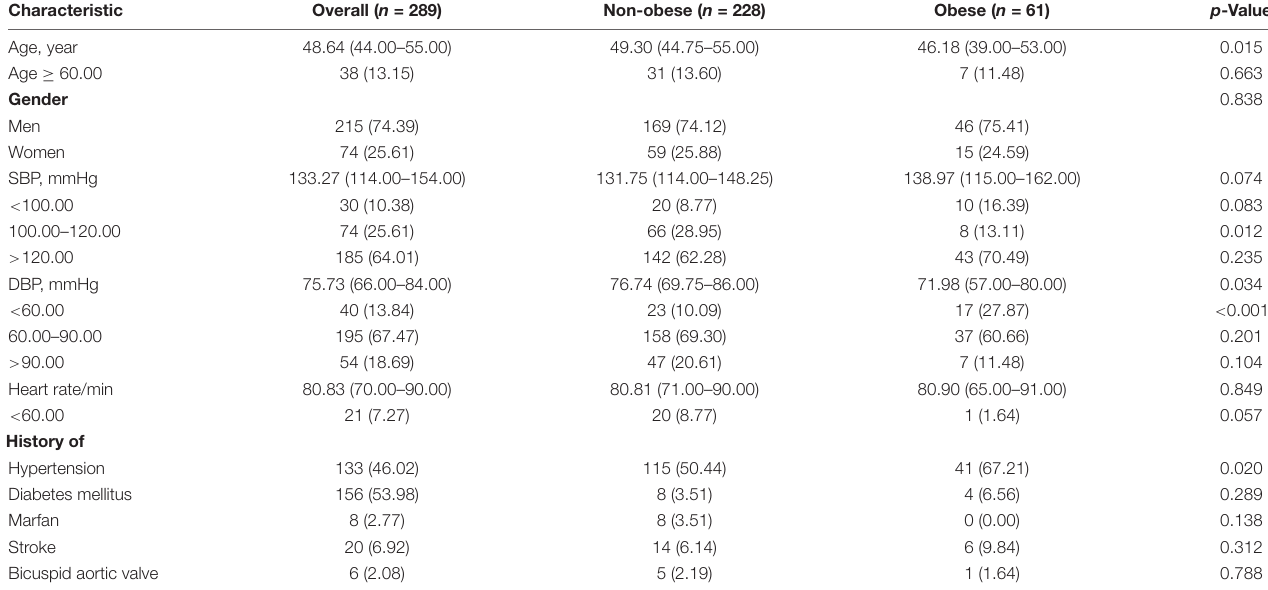
TABLE 1 | Baseline characteristics of the patients.